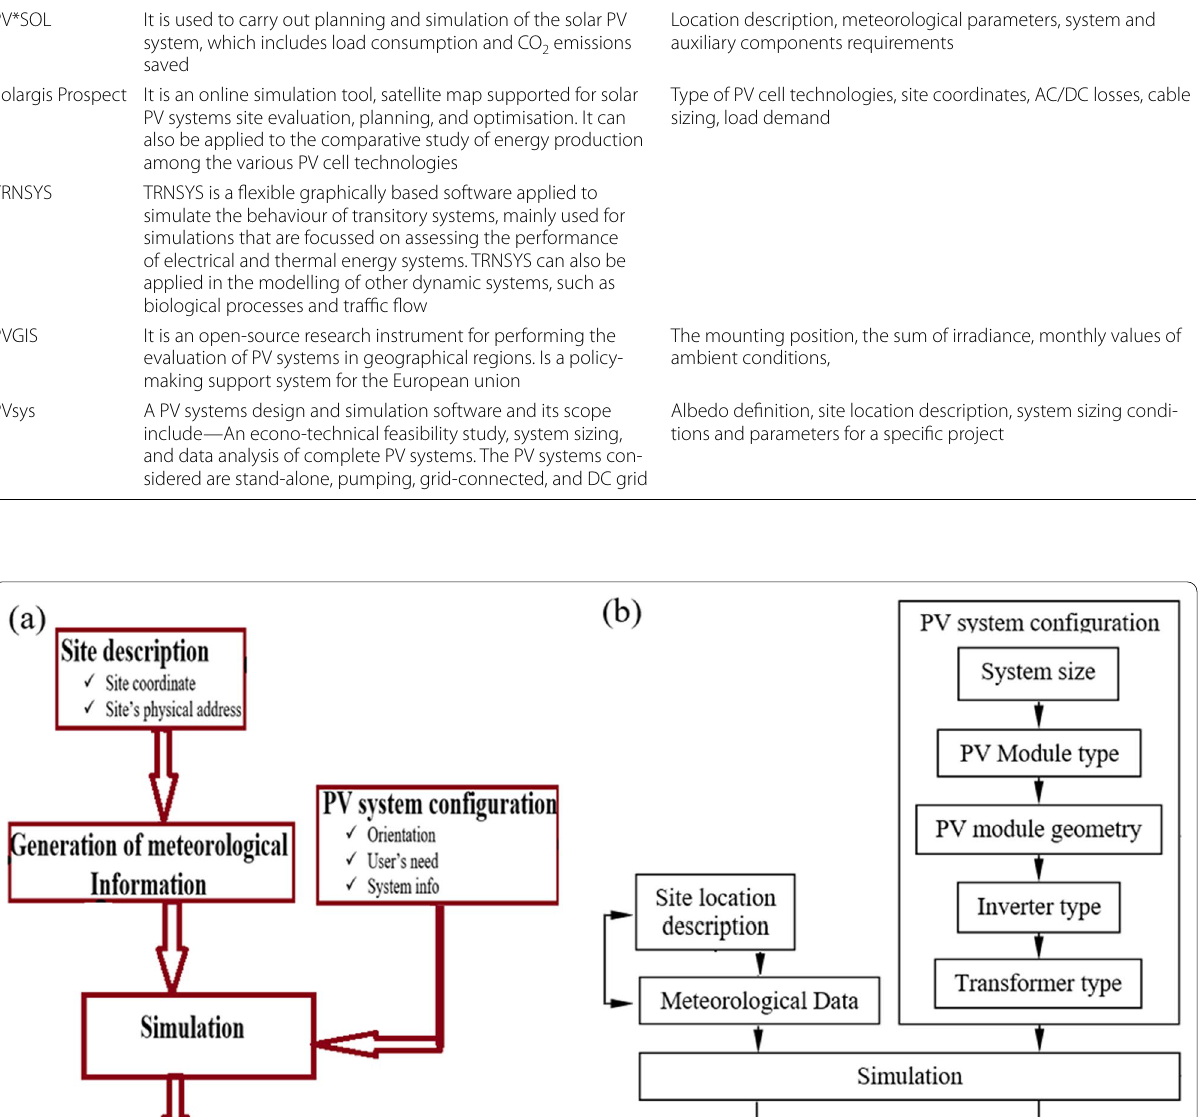
Table 1 Software applications used for solar PV systems performance analysis (Dondariya et al. 2018; Fuzen 2021; Khatib et al. 2012) Software